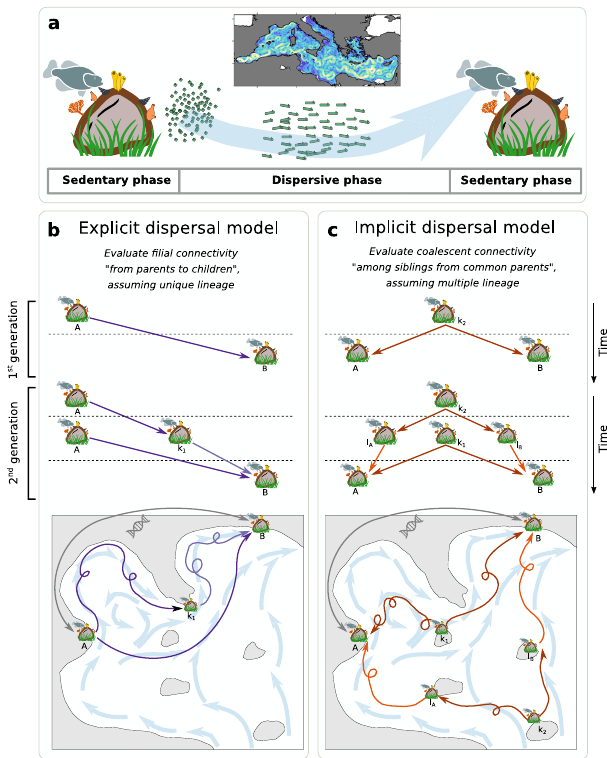
Fig. 2 | Modelling multi-generational water-borne dispersal. a Schematic representationofabiphasiclifecyclecomposedofsedentaryadultsanddispersive early-life stages, that is a distinctive feature of all species included in the meta- analysis. During the dispersive phase, numerous individuals are dispersed across the seascape by turbulent currents (represented in the Mediterranean miniature). b Explicit dispersal model evaluates fi lial connections between locality-pairs. c Implicitdispersalmodelestimatescoalescentconnectionsbetweenlocality-pairs. Schematics highlight the simulated genealogy over two generations and illustrate one of many multi-generational dispersal pathways that are considered by our models when estimating the connectivity between distant localities A and B. Icons credit: ©vectorsmarket,© Agne Alesiute,©ElisabettaCalabritto,© Luis Prado, ©